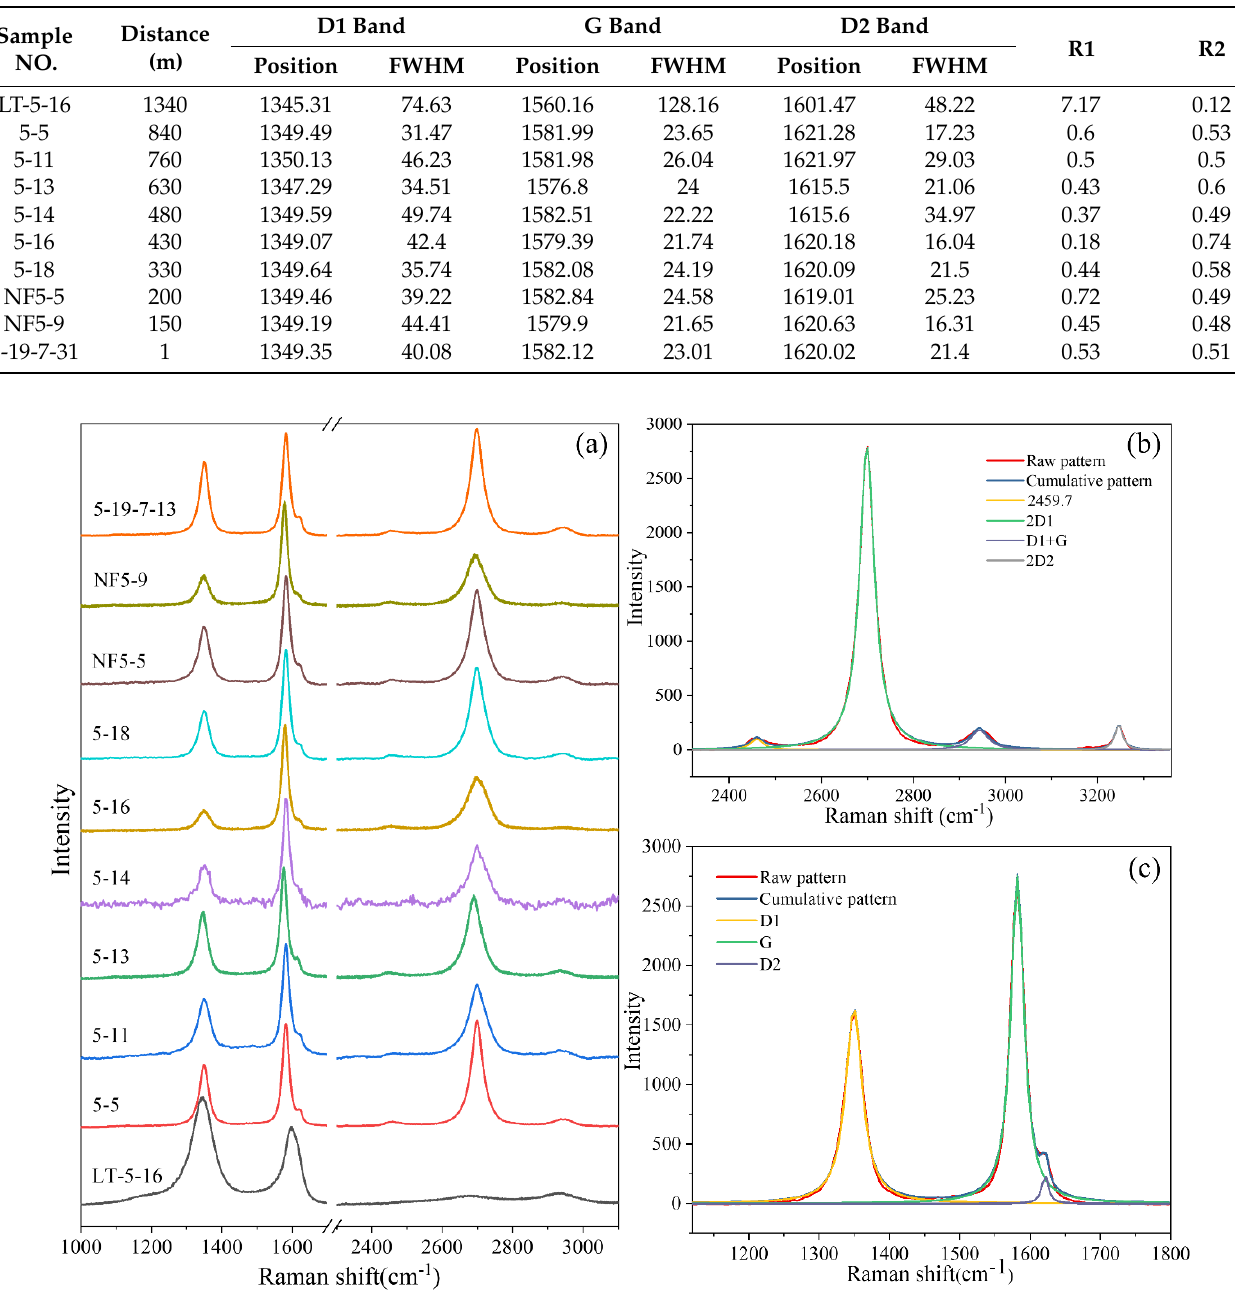
Figure 4. ( a ) Raman spectra of series coal seam-derived graphite samples, ( b ) peak fitting of Raman spectrum in the first-order region in case of sample 5-5, and ( c ) peak fitting of Raman spectrum in the second order region in case of sample 5-5.